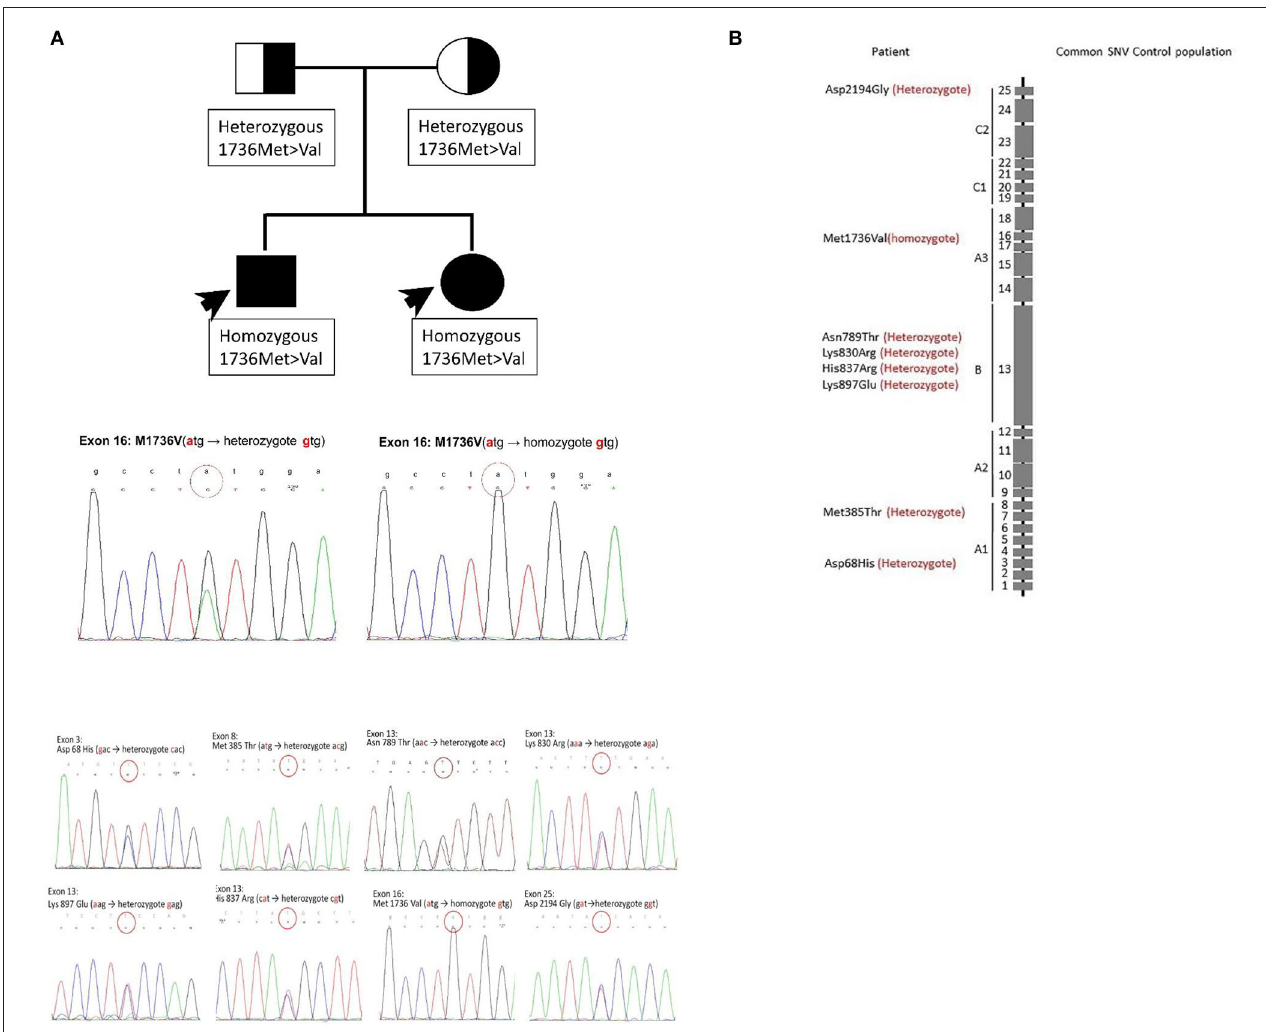
FIGURE 1 | Mutation results of the patient and his family. In this family, two members had a coagulopathy disorder. (A) The pedigree chart. The FV deficiency was only noted in their children. The results of the F5 gene analysis for their children are the same and shown at the bottom. Crucial mutations in this family. Homozygous Met1736Val and other seven heterozygous mutations coexisted. (B) Those mutation sites are demonstrated. The graph shows the absolute location of the mutation sites on the FV gene. The location of eight mutation sites on the chromosome. The mutation sites are demonstrated